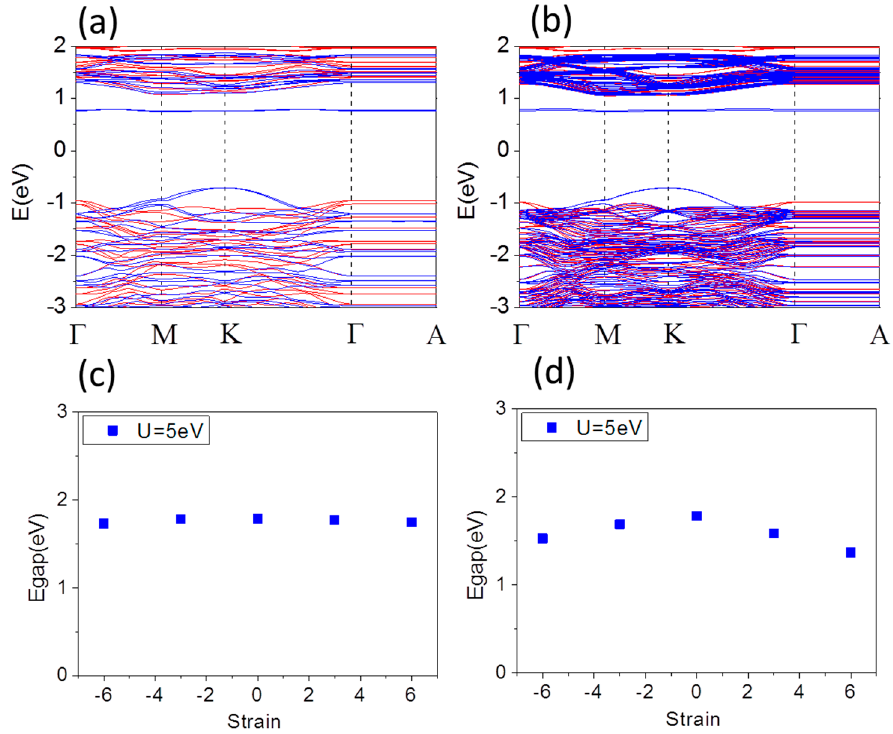
Figure 2. Band structure of Fe terminated α -Fe 2 O 3 : 1 × 1 × 1 film ( a ); and 1 × 1 × 3 film ( b ); for lattice constant a = 5.035 Å at U = 5 eV. Band gap of Fe terminated α -Fe 2 O 3 : 1 × 1 × 1 film ( c ); and 1 × 1 × 3 film ( d ), as a function of strain.